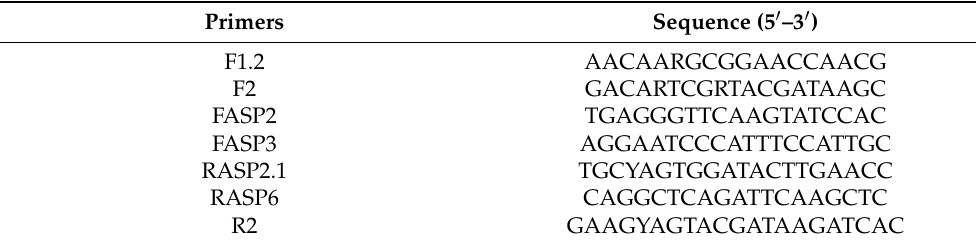
Table 1. Designed and synthesized degenerate primers for the identification of L-asparaginase gene sequence from P. sizovae .